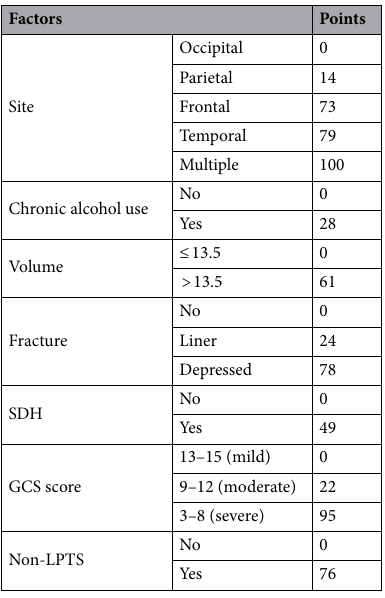
Table 4. The corresponding scoring system table of Nomogram. SDH subdural hematoma, GCS glasgow coma scale, LPTS late post-traumatic seizure.